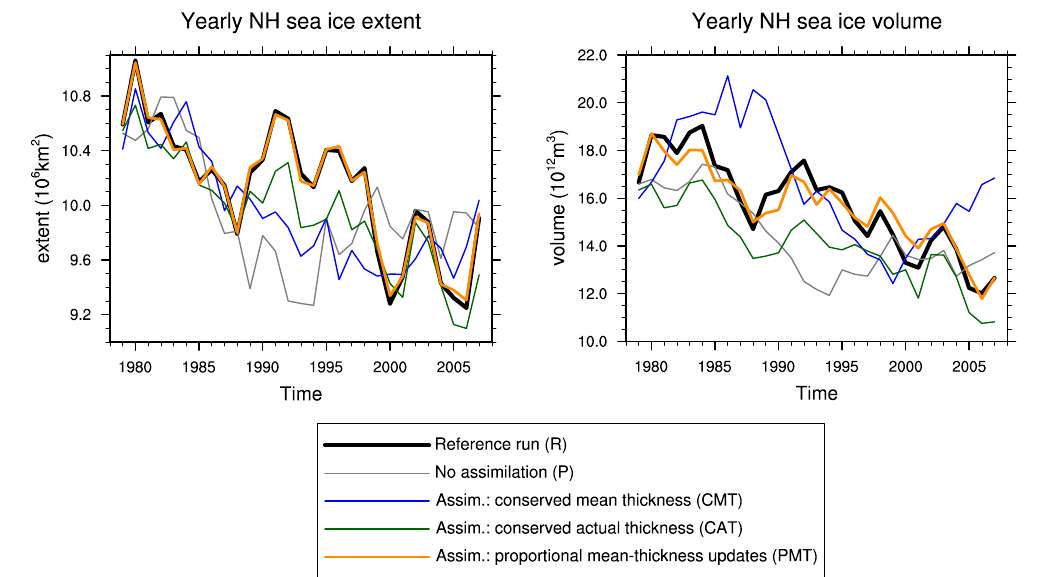
Fig. 1. Annual mean sea-ice extent (left) and sea-ice volume (right) in the Northern Hemisphere for the identical-twin study. Shown are the reference run (black), the perturbed run with no assimilation (grey), and the assimilation runs (colours) that assimilate sea-ice concentration from the reference run. The corresponding time-averaged global extent and volume errors δ SIE and δ SIV are given in Table 1.